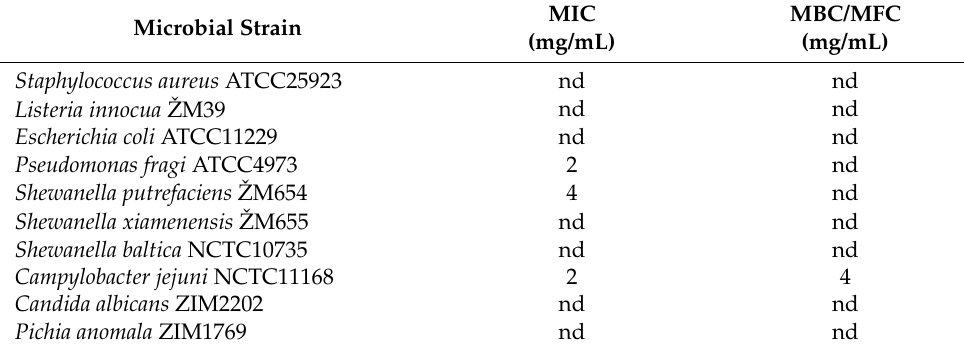
Table 4. Antimicrobial activity of the CE fennel seeds extract expressed as MIC and MBC/MFC. Microbial Strain Staphylococcus aureus ATCC25923 nd nd Listeria innocua ŽM39 nd nd